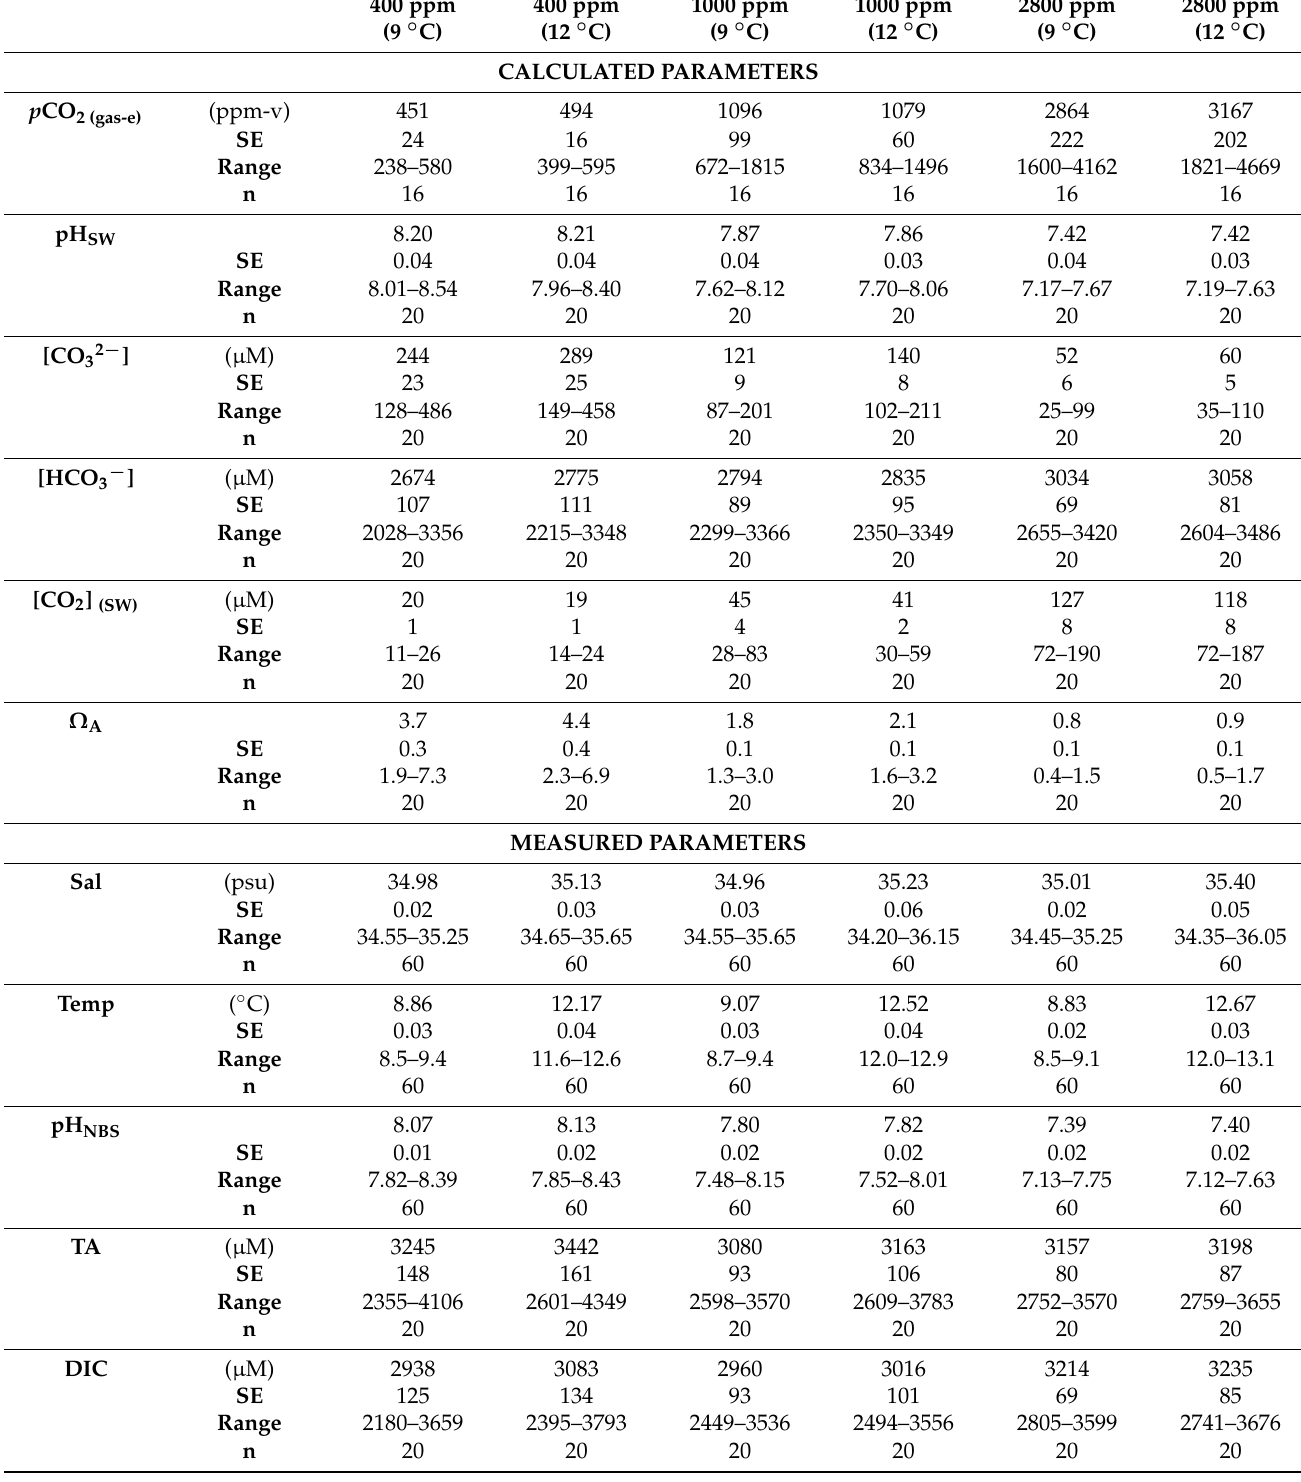
Table 2. Average calculated parameters for Lophelia pertusa and all treatments: pCO 2 of the mixed gases in equilibrium with seawaters (pCO 2 (gas-e)), pH on seawater scale (pH SW ), carbonate ion con- centration ([CO 32 − ]), bicarbonate ion concentration ([HCO 3 − ]), dissolved carbon dioxide ([CO 2 ] SW ), and aragonite saturation state ( Ω A ). Average measured parameters for all treatments: salinity (Sal), temperature (Temp), pH on NBS scale (pH NBS ), total alkalinity (TA), and dissolved inorganic carbon (DIC). ‘SE’ represents standard error and ‘n’ is the sample